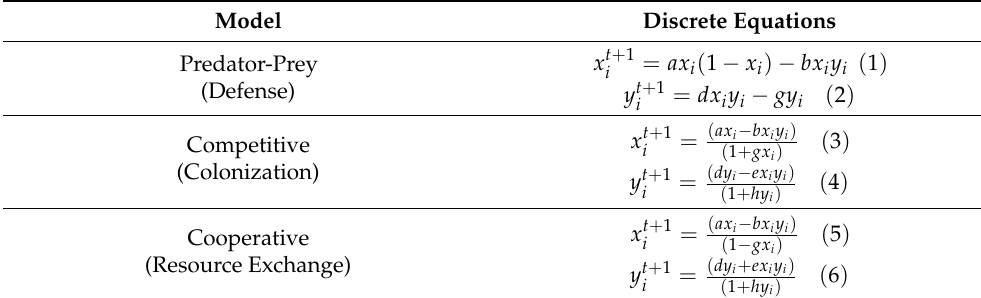
Table 1. Lotka–Volterra Discrete Equation System.